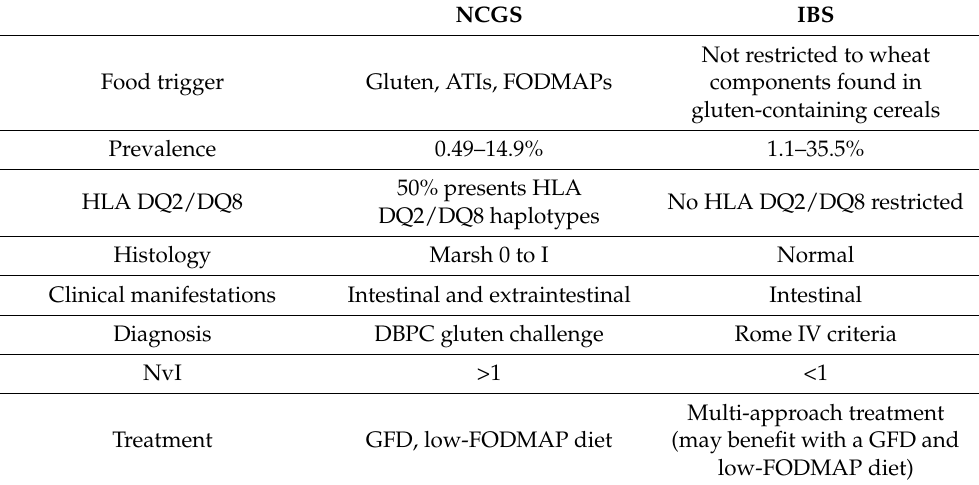
Table 4. Comparison among NCGS and IBS